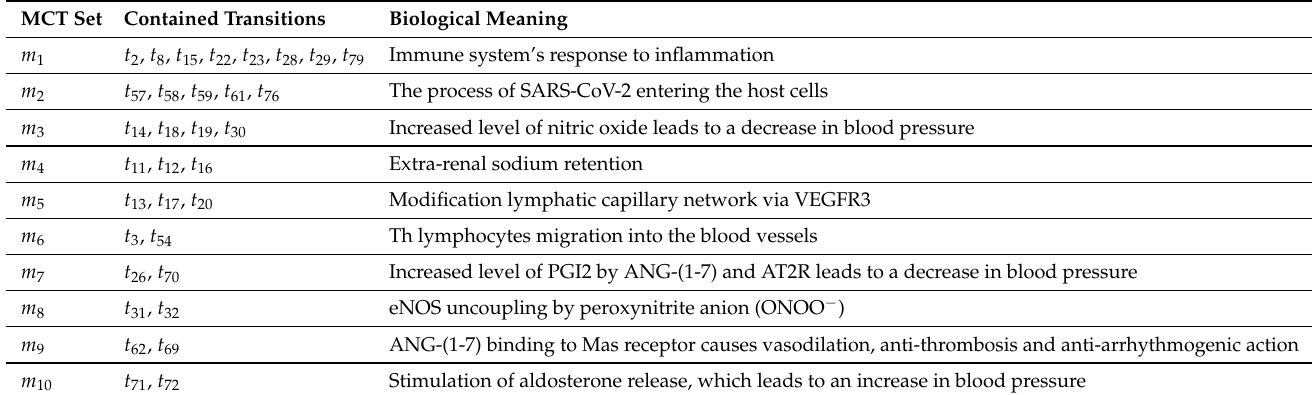
Table 6. List of non-trivial MCT sets for the model with SARS-CoV-2 (for all